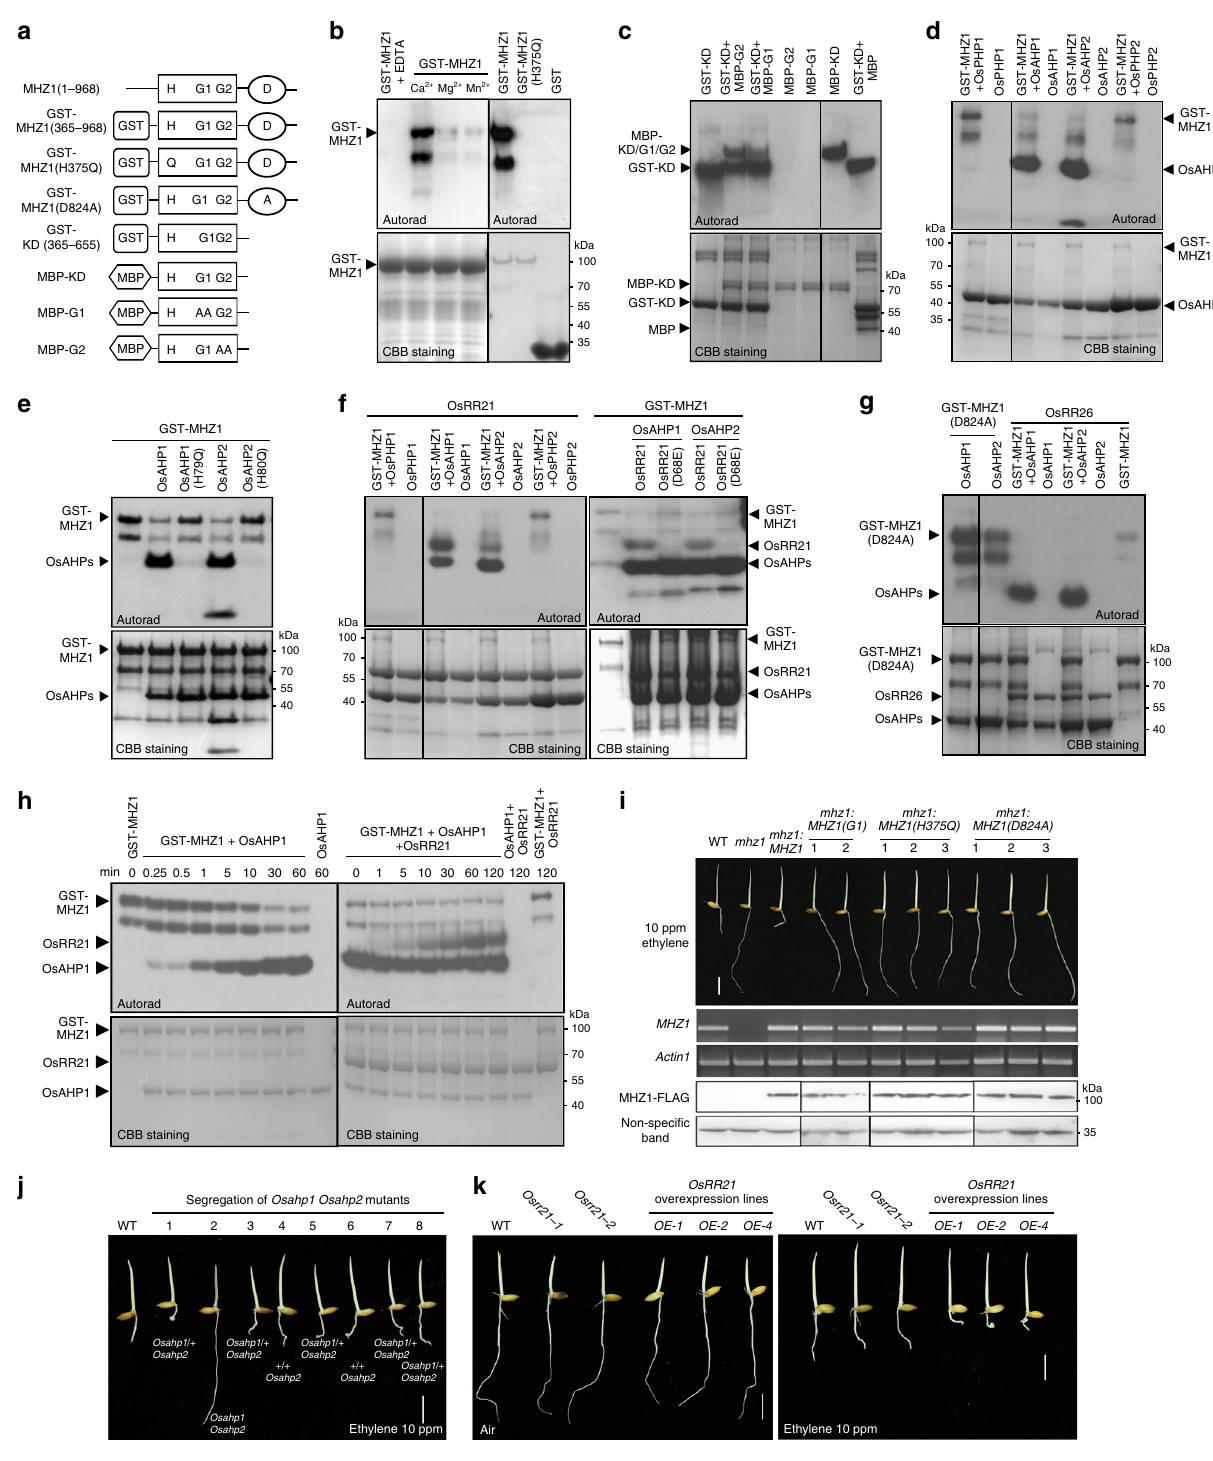
the OsRR21 but not OsRR26 can accept the phosphoryl group transferred from the phosphorylated OsAHP1 or OsAHP2 (Fig. 3f, g), suggesting substrate speci fi city. D68E mutation of OsRR21 abolished its phosphorylation (Fig. 3f, right panel), suggesting that D68 may be the phosphoryl-accepting site. D824A mutation in the receiver domain of GST-MHZ1 disabled the phosphorelay from MHZ1 to OsAHP1 or OsAHP2 (Fig. 3g, the left two lanes), indicating that the D824 residue of MHZ1 is indispensable for phosphotransfer from GST-MHZ1 to OsAHP1 or OsAHP2. All these results support that MHZ1